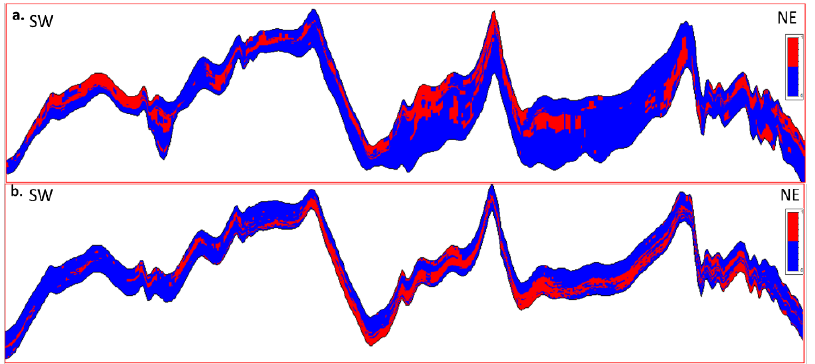
Figure 25. SW – NE intersections of net to gross model of Unit 4 ( a ) and Unit 5 ( b ). More effective reservoirs in Unit 4 exist in the south of the field, while Unit 5 has more effective reservoirs in the north.